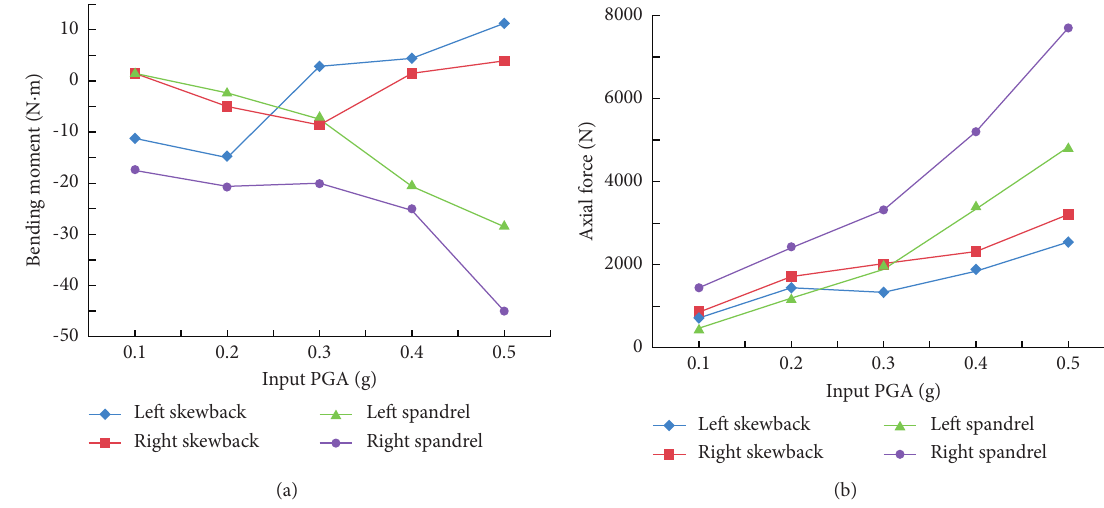
Figure 10: Time-history diagram of internal force. (a) Maximum bending moment. (b) Maximum axial